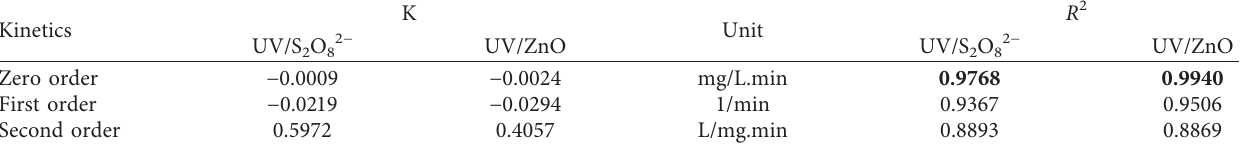
Table 1: Summary of the kinetic analysis results of trifluralin removal in optimal